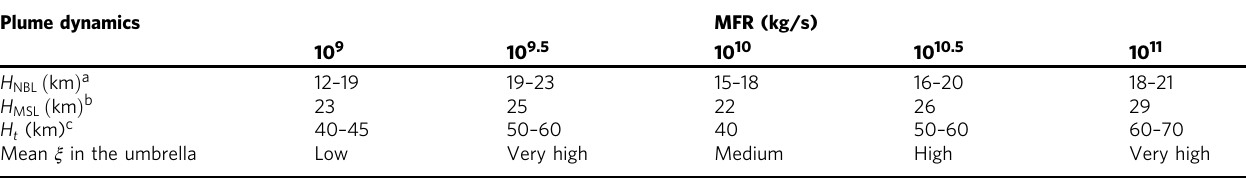
a The lower value corresponds to the column region, while the upper value to the entire umbrella region b The radial maximum spreading level was estimated as the height containing the greatest mass of airborne particles 34 c The lower value corresponds to dilute part of the plume ( ξ = 10 − 3 ), while the upper value to the concentrated part of the plume ( ξ = 10 − 1 )